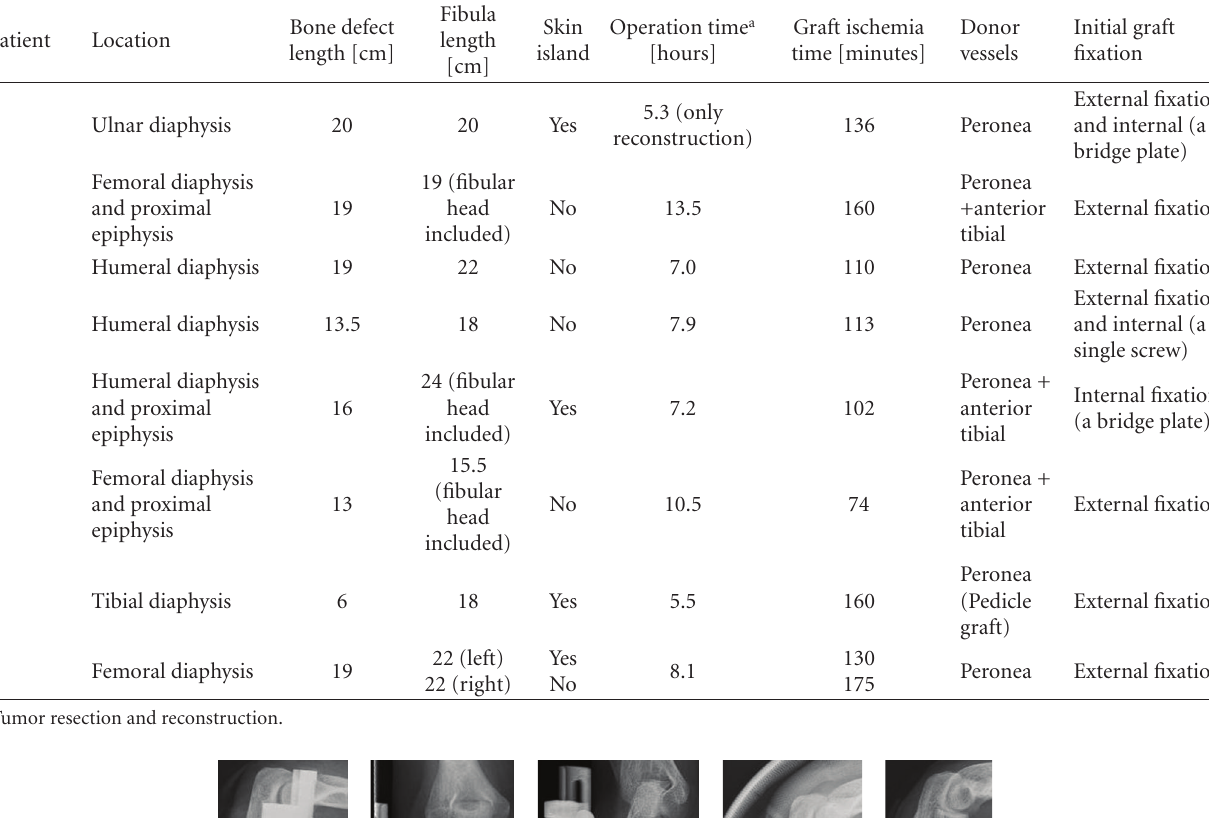
Table 2: Operative data.